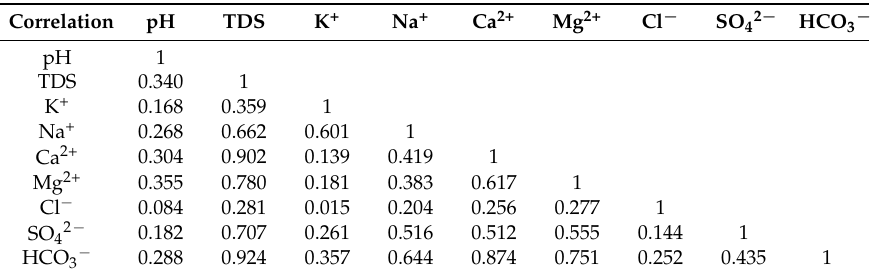
Table 1. Correlation matrix of the species in water samples.